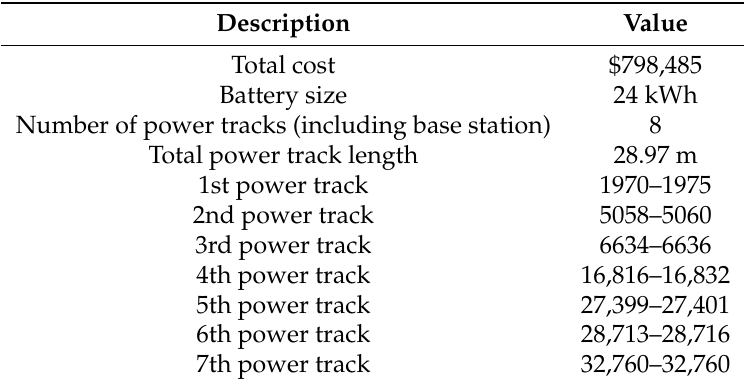
Table 3. Summary of the optimization results for the Gumi City case (for k =